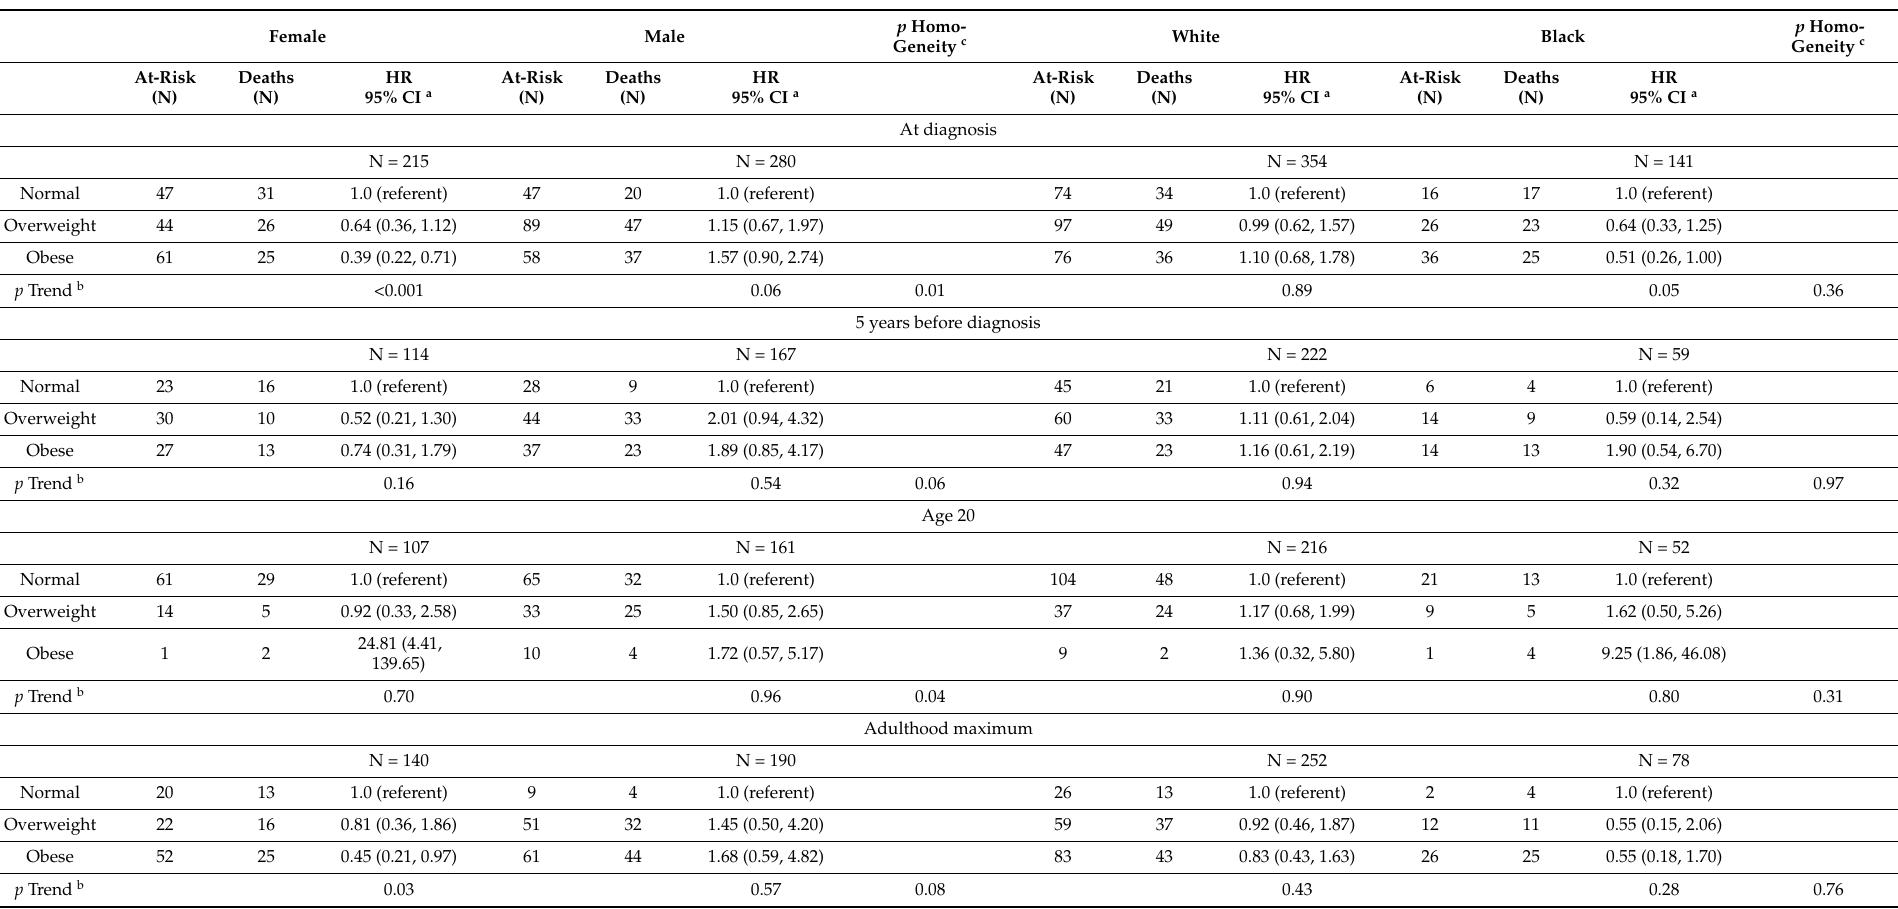
Table 3. Sex- and race- specific associations of body mass index (BMI) at multiple myeloma (MM) diagnosis and pre-diagnostic BMIs with overall survival among patients with MM in fully adjusted multivariable models